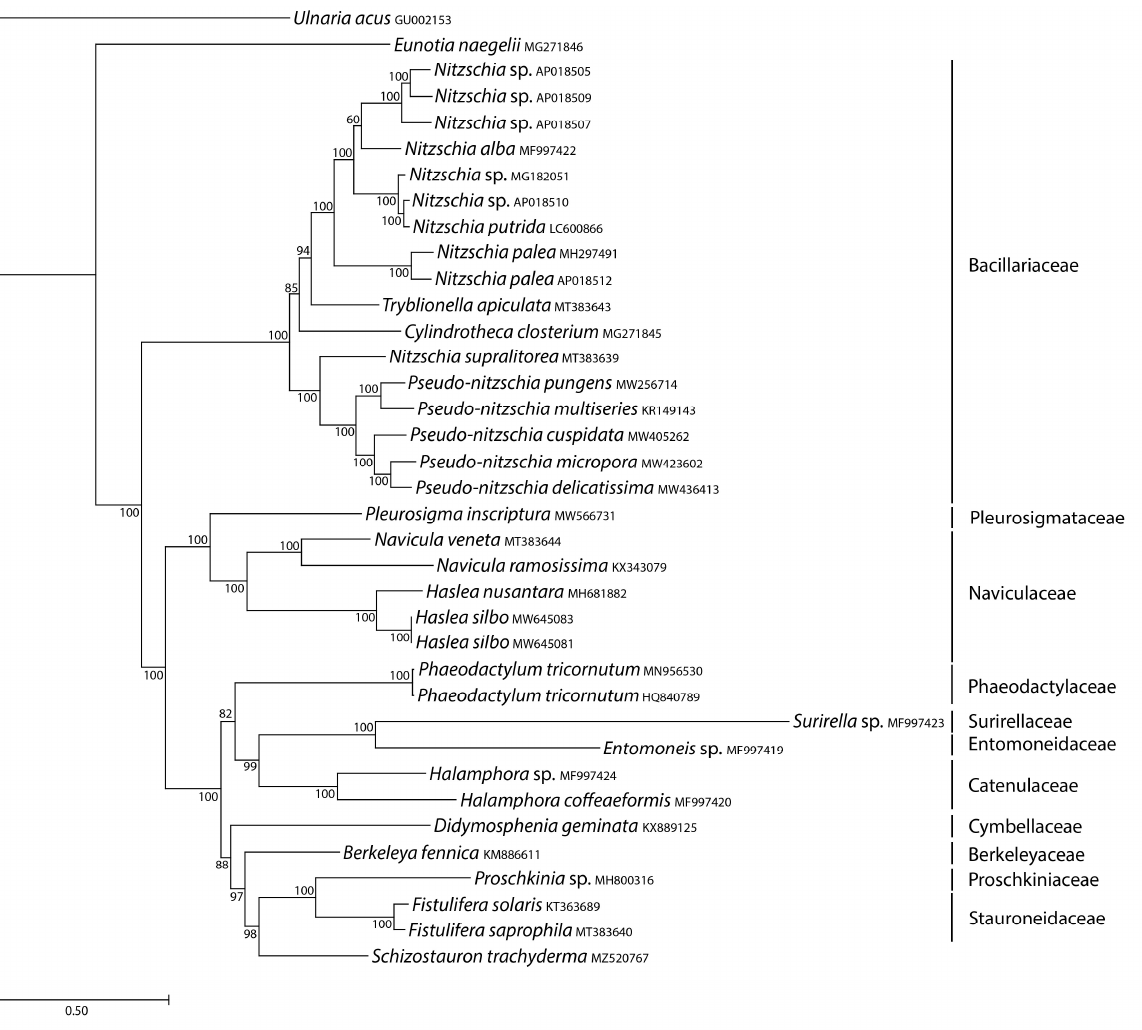
Figure 7. Maximum likelihood phylogeny inferred from an alignment of concatenated protein-coding genes from 37 mitochondrial genomes of diatoms, including that of S. trachyderma . The araphid species Ulnaria acus served as an outgroup in this analysis. The best scoring RAxML tree (log likelihood = − 414469.369802) is presented with bootstrap support values denoted on the nodes. The scale bar indicates the number of substitutions per site. The araphid species Ulnaria acus is used as an outgroup.